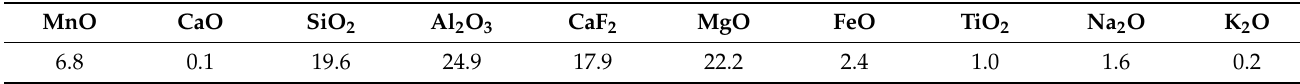
Table 2. Flux bulk chemical composition (mass%).